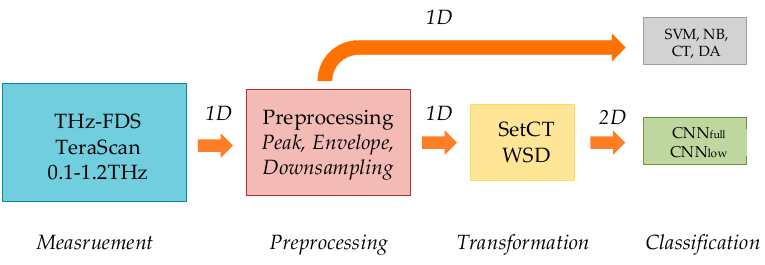
Figure 13. The experimental procedure.